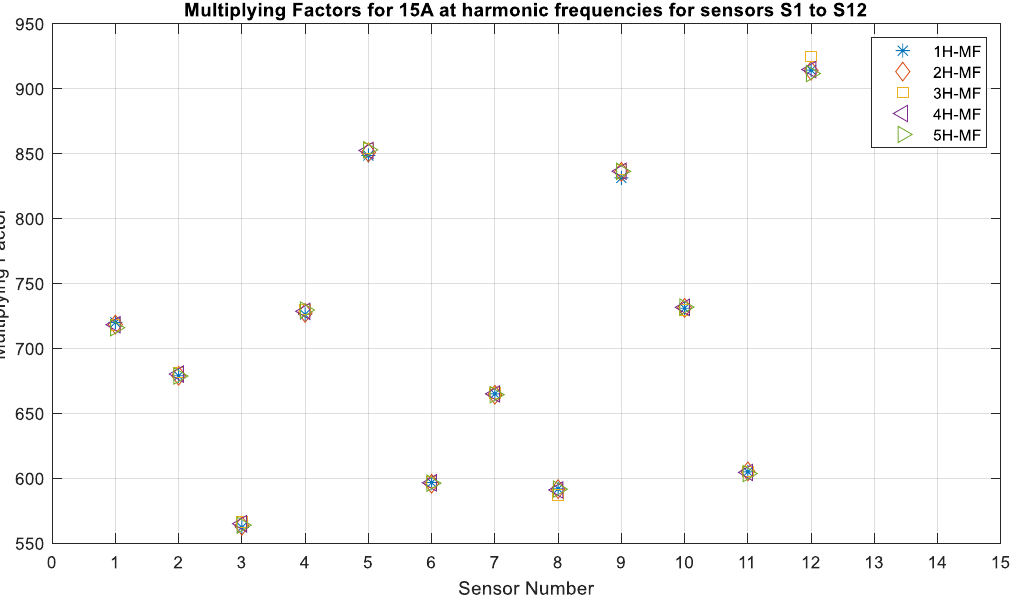
Figure 19. Multiplying factors of all sensors for 15 A, 7 mm, 60 Hz and its harmonics: WI and NI cases.